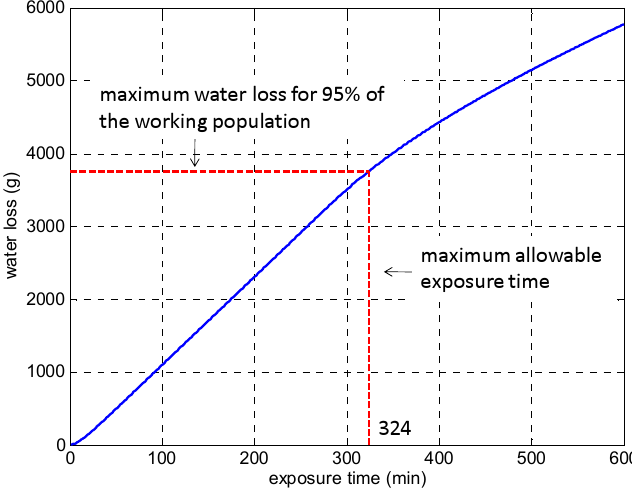
Figure 3. Variation of water loss with exposure time.